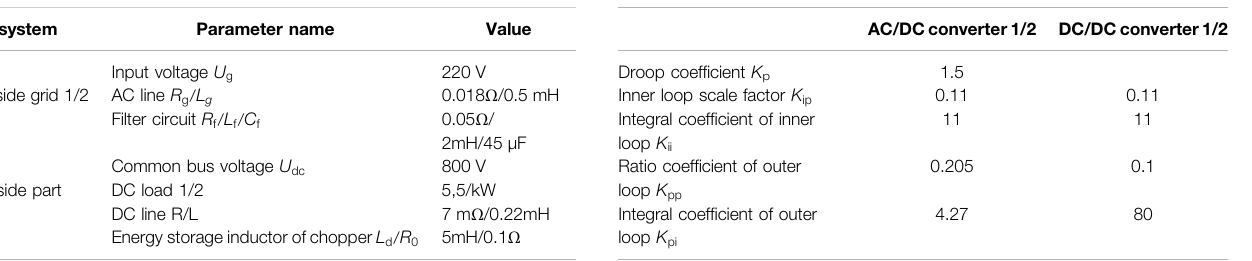
TABLE 1 | DC distribution system parameters. TABLE 2 | Converter control